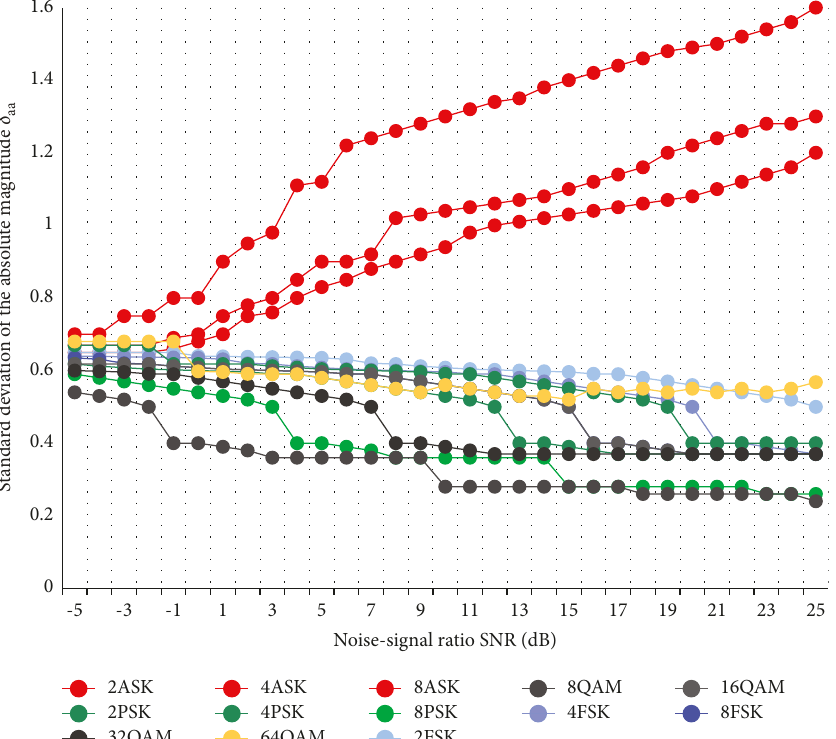
with the signal-to-noise ratio under different social network crisis data methods. max